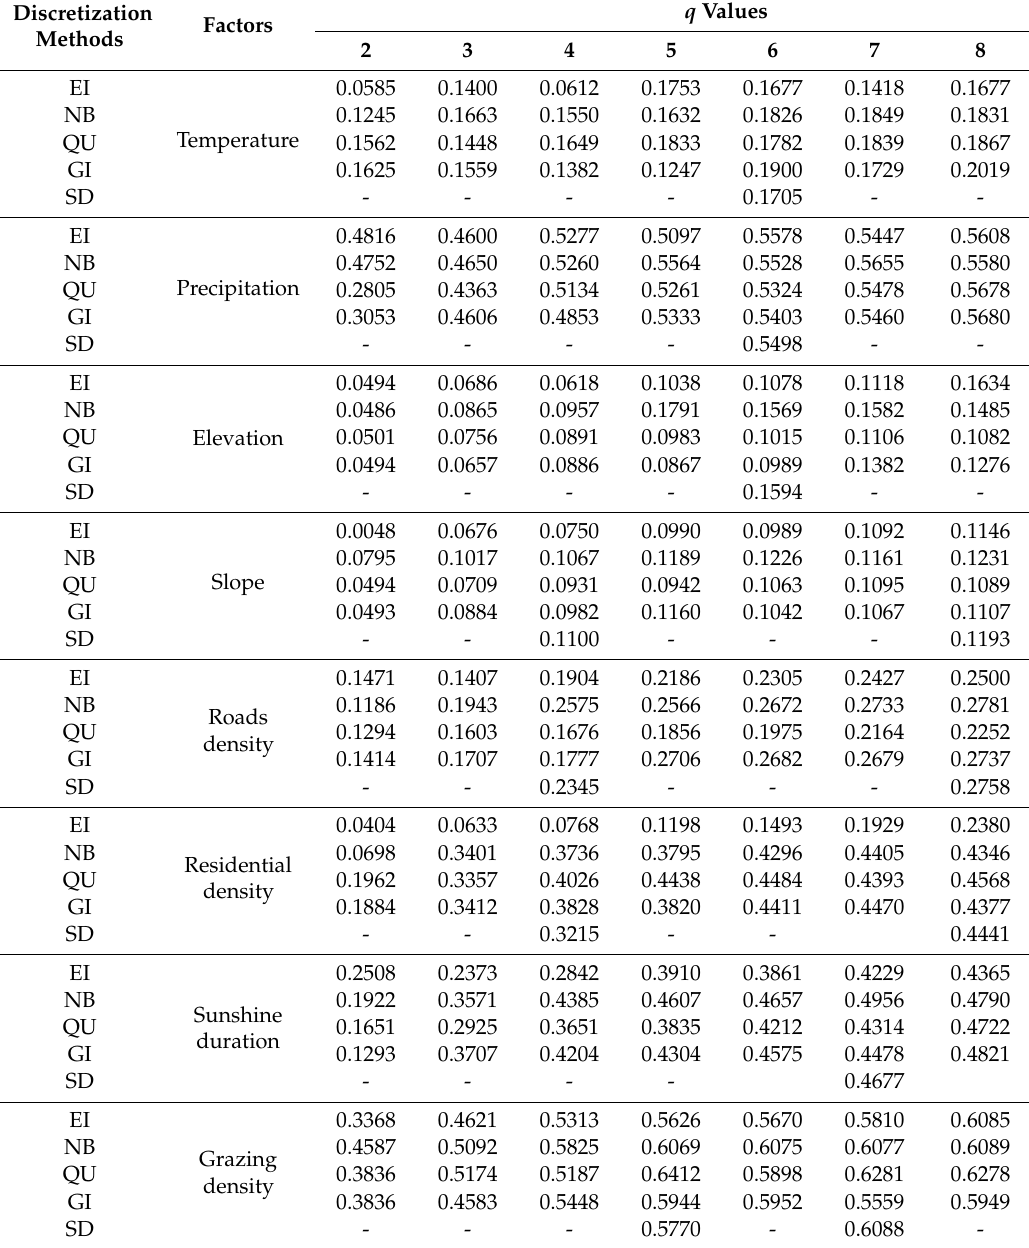
Table A1. The q values of continuous impact factors in each preliminary classification